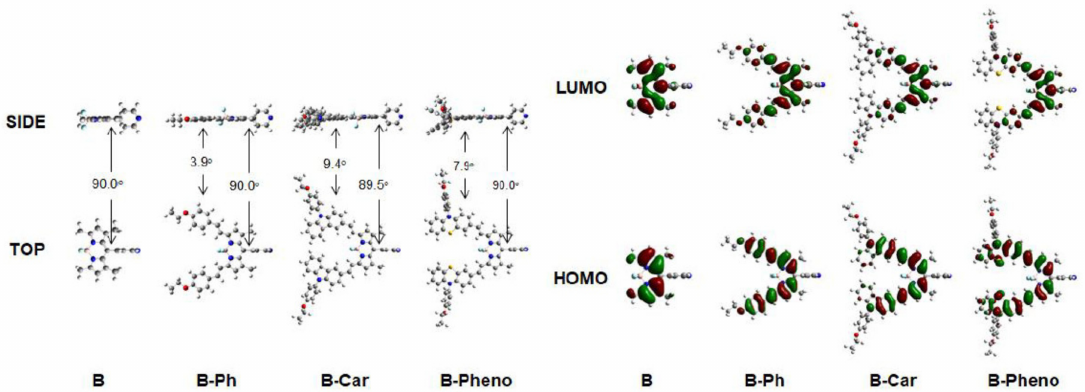
Figure 3. ( Left ) Optimized structure at B3LYP / 6-31G(g) level and dihedral angles of B , B-Ph , B-Car , and B-Pheno . ( Right ) HOMO and LUMO orbitals of B , B-Ph , B-Car , and B-Pheno .